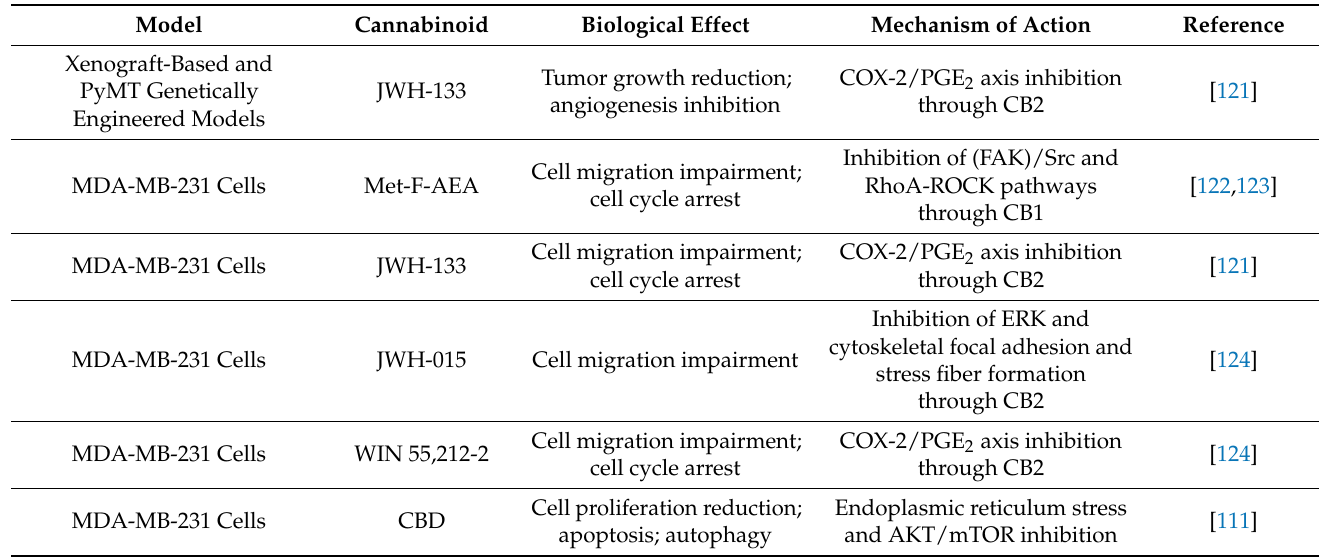
Table 2. Antitumor effects of cannabinoids in